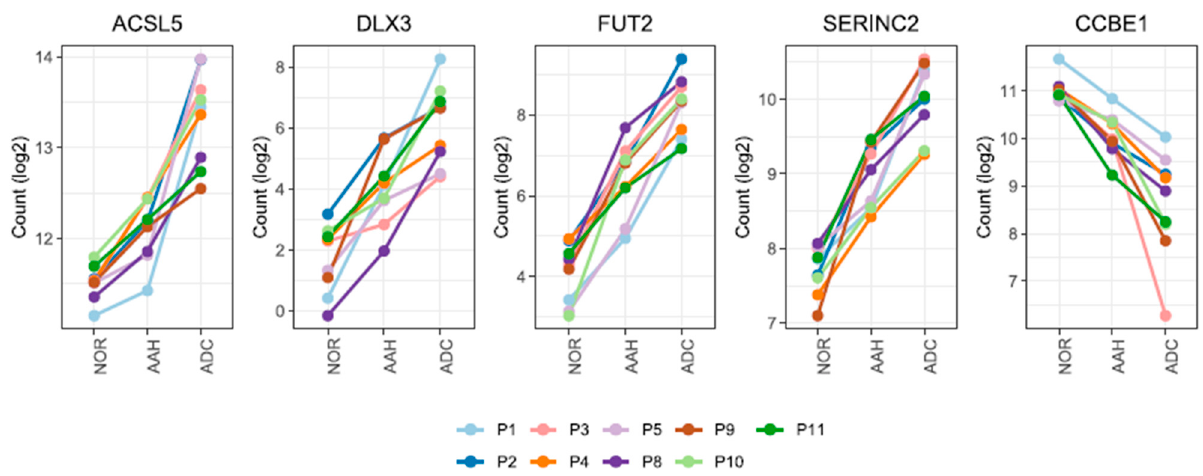
Figure 2. The mRNA expression patterns of five genes from normal and lung cancer tissue samples. Five genes are differentially expressed with a 1.2-fold change (AAH to normal tissue, ADC to normal tissue, and ADC to AAH) in all nine patients. Only FUT2 remained as the candidate gene when a fold-change cut-off of 1.5 was applied. The patient specimens and the numbers were obtained from a previous study [8,17]. Read count values (log2) are presented for 36 samples across 3 different tissues. AAH, atypical adenomatous hyperplasia; ADC, adenocarcinoma; NOR, normal.